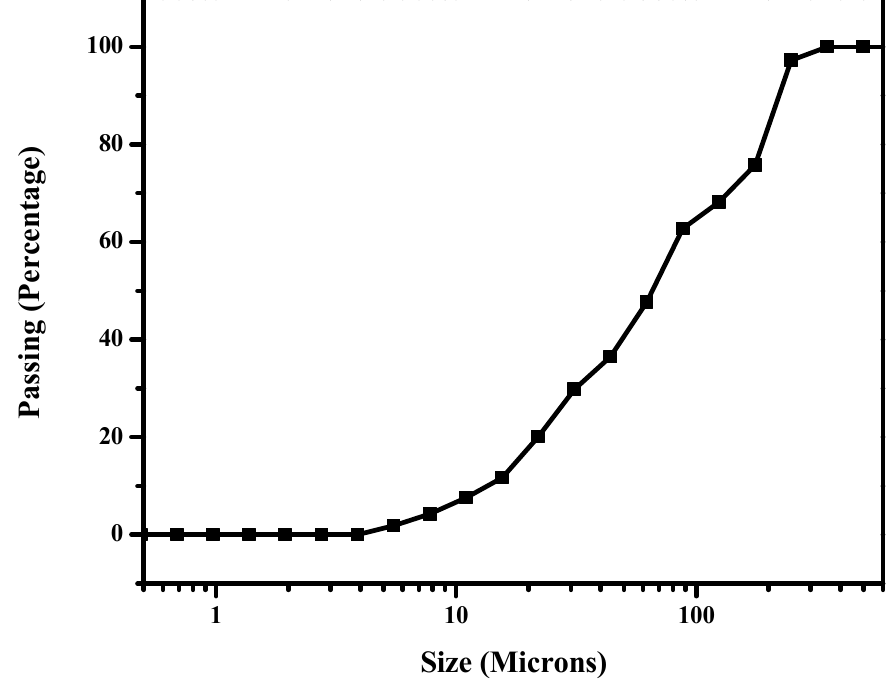
Figure 1. Particle size distribution of GGBFS.